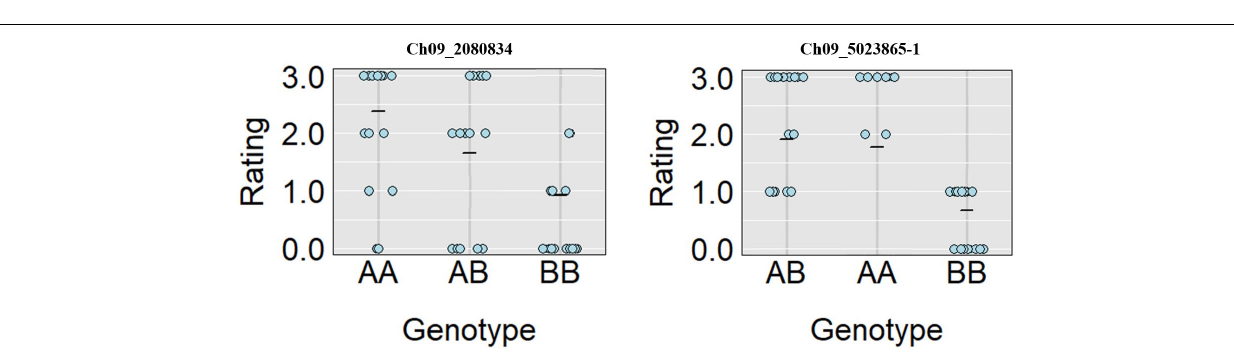
Frontiers in Plant Science |